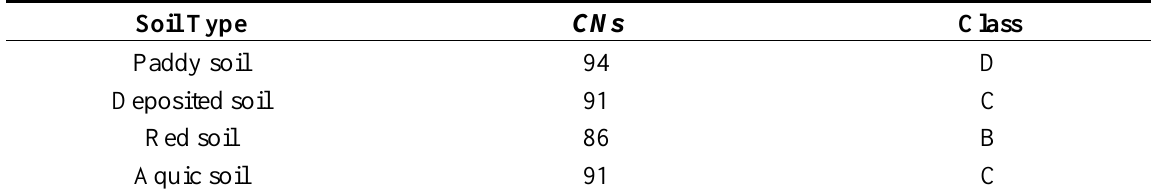
Table 1. The value of CNs and class.